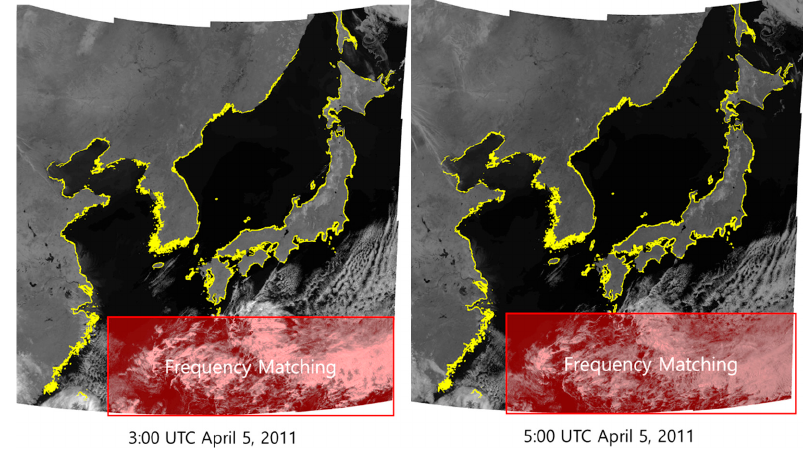
Figure 14. The result of the experiments.